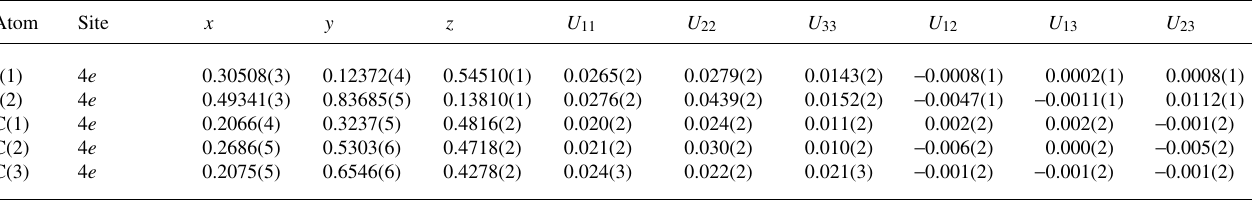
Table 3. Atomic coordinates and displacement parameters (in Å 2 )